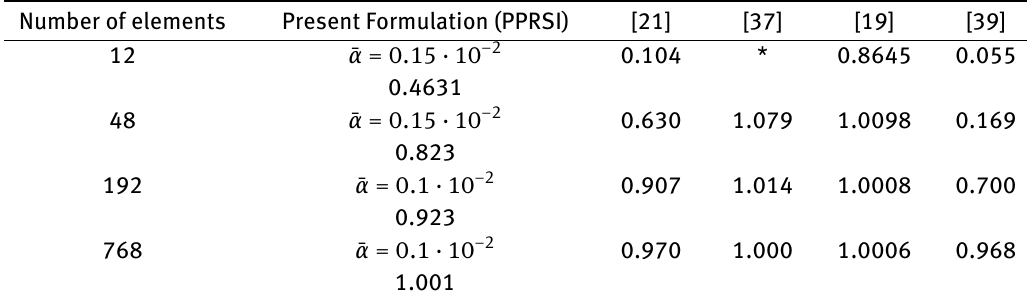
Table 4: Fourth model case (a full dome without a hole) solved using 9-node element, compared with exact solution 0.0924 mm. FE displace- ment and new approach PPRSI vs. analytical expression